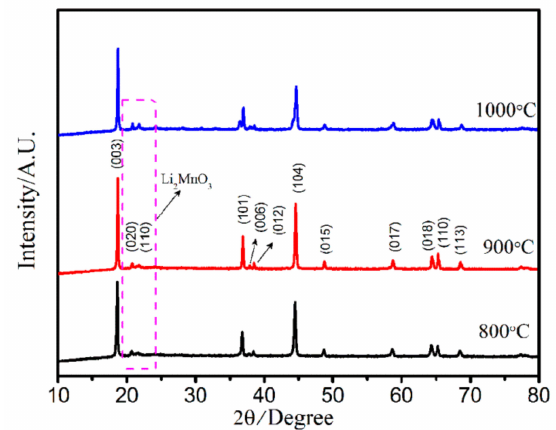
Figure 1. XRD patterns of Li[Li 0.2 Mn 0.56 Ni 0.16 Co 0.08 ]O 2 prepared at di ff erent temperature. The SEM images of the Li[Li 0.2 Mn 0.56 Ni 0.16 Co 0.08 ]O 2 materials calcined at di ff erent